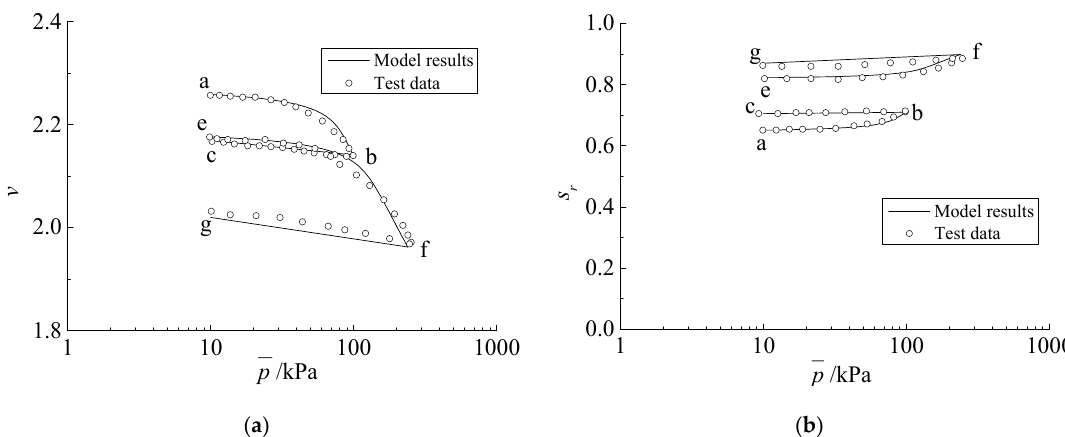
Figure 7. Comparison between modeling results and Test 10 measured data for bentonite / kaolin mixture under isotropic loading–unloading cycles and the wetting–drying cycle: ( a ) specific volume; ( b ) saturation degree.